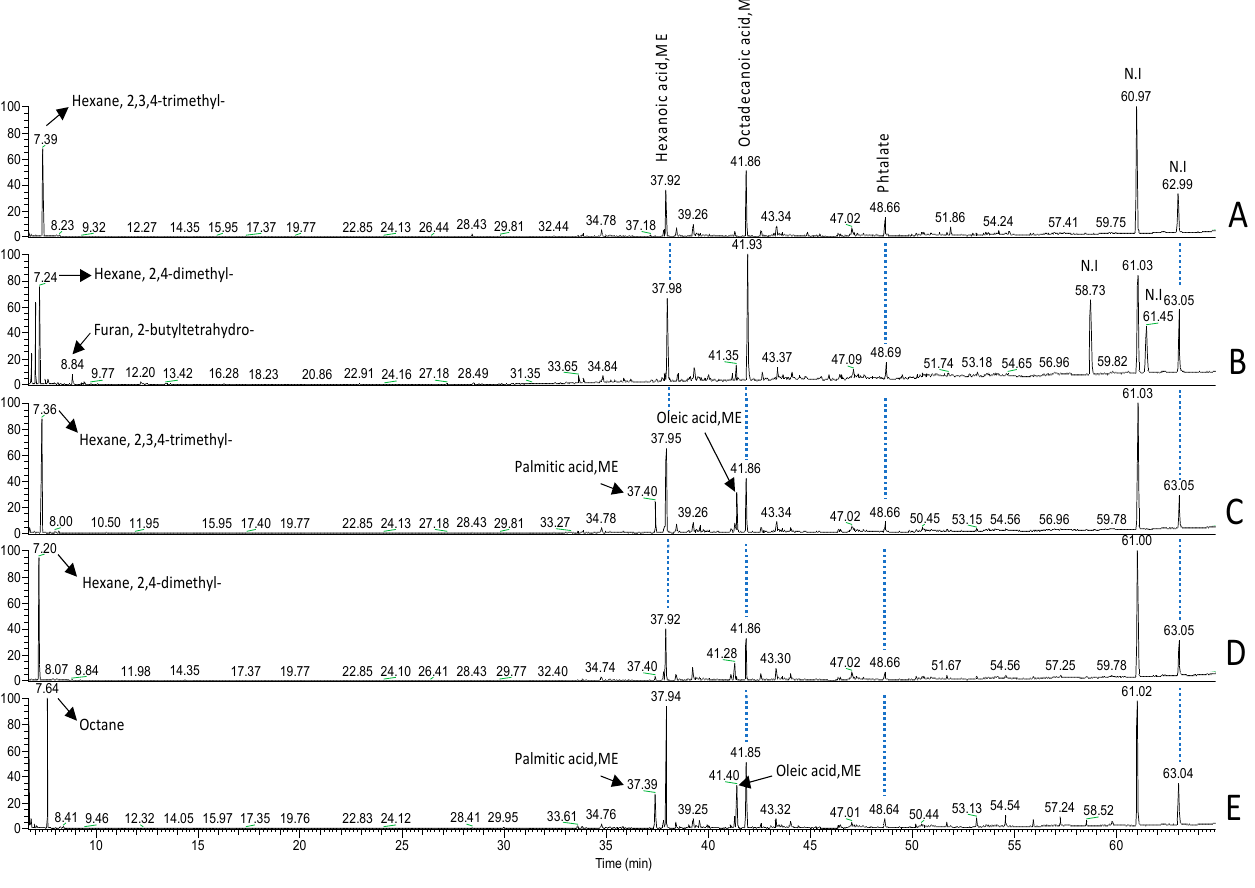
Figure 1. Representative data of the analysis obtained using GC-MS . ( A ) Analysis of RPMI medium. ( B ) Analysis of a control mouse colon sample. ( C ) Analysis of a mouse colon sample incubated with L. johnsonii and B. thetaiotaomicron . ( D ) Analysis of a mouse colon sample incubated with C. glabrata . ( E ) Analysis of a mouse colon sample incubated with L. johnsonii, B. thetaiotaomicron, and C. glabrata . The retention time (RT) peak of 6.85 min corresponded to tetrahydrofuran, 2-methyl-5-methyl; while the RT peak of 7.04 min was not identified in chromatogram